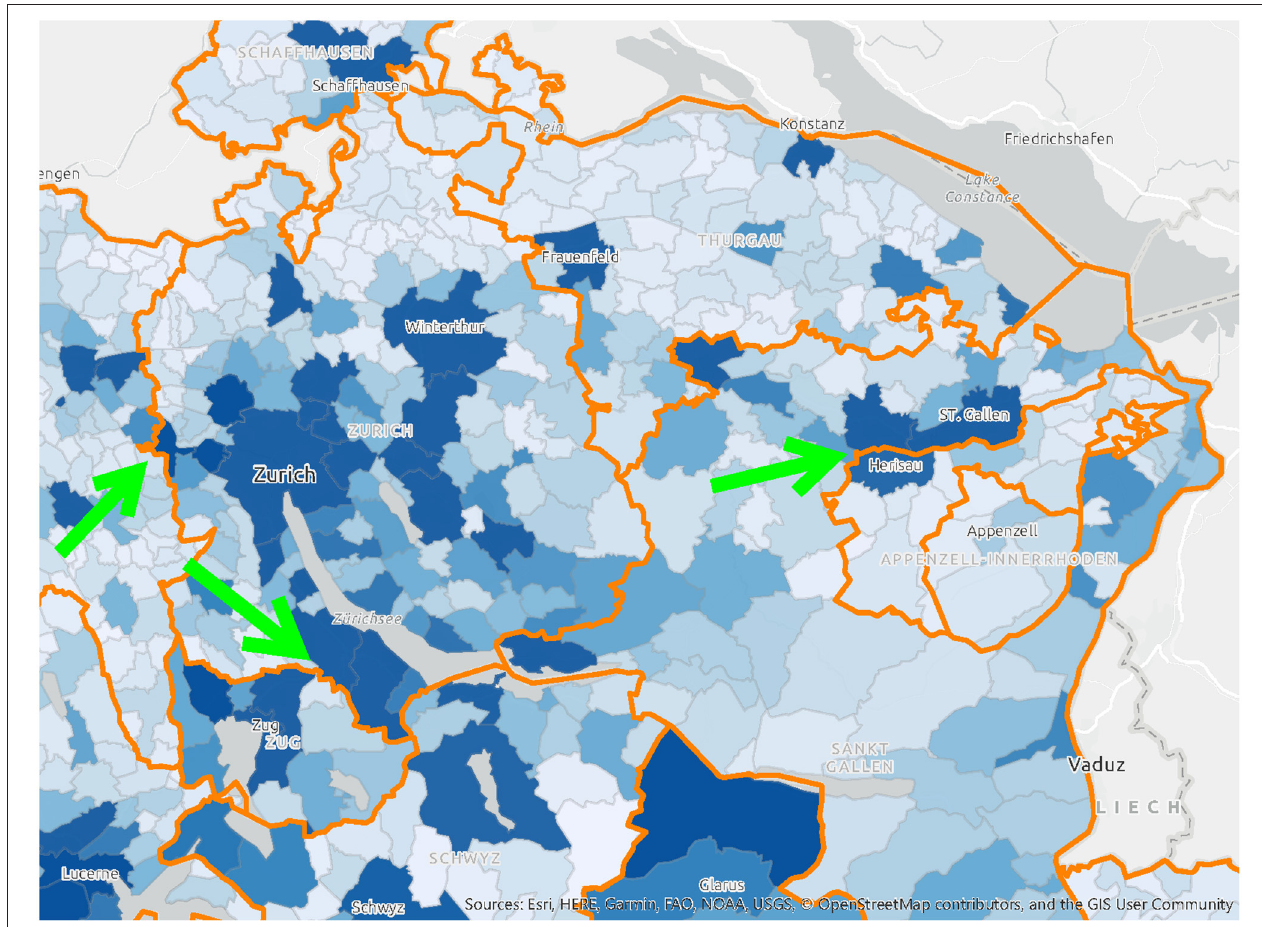
FIGURE 4 | A map of population distribution and cantonal borders in Switzerland, highlighting the areas where these borders cut through high-density areas. Source: drafted by authors from data sources ( 37), Basemap: